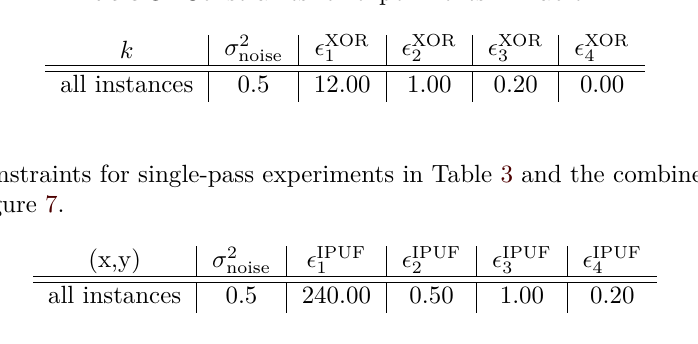
Table 5: Constraints for experiments in Table 2.